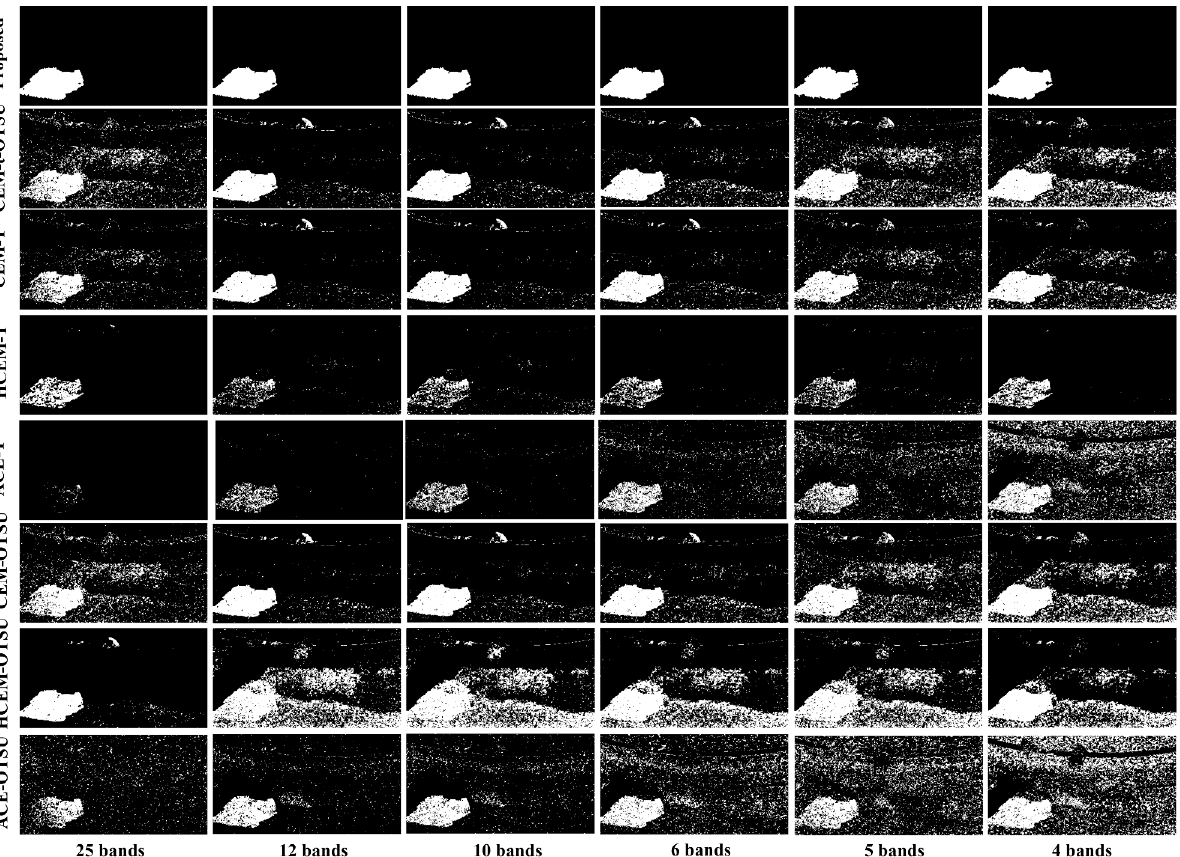
Figure 16. The detection results of the ASRC-net in the BF scene (35 mm focal length) with bands ranging from 4 to 25. All results are normalized to [0,1] for a fair comparison.